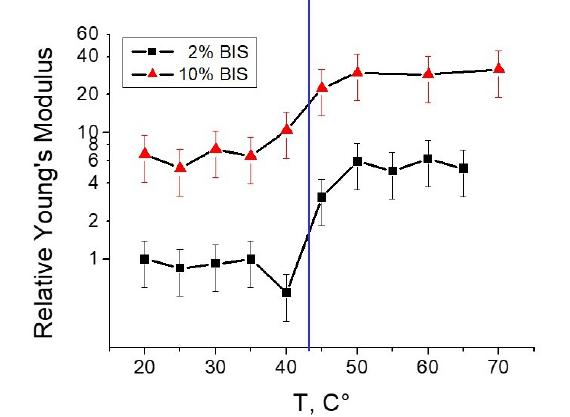
Figure 2. PNIPAM microgels copolymerised with about 2.5% AAc. The amount of cross-linker is either 2% or 10%. Taken from